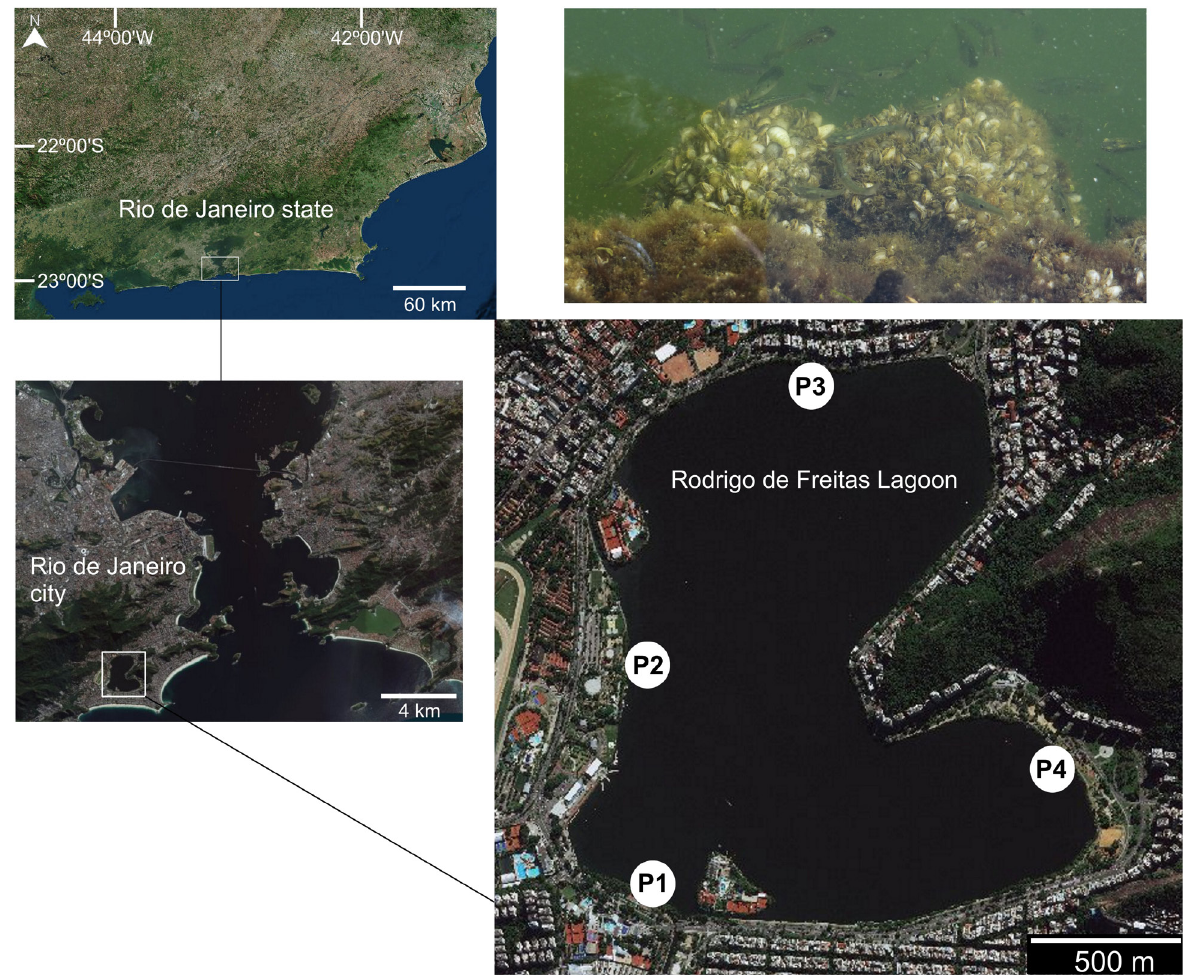
Figure 1. Satellite images of the Rodrigo de Freitas Lagoon (modified from ArcGIS Online), showing the four sampling sites (P1 to P4). Top right: clusters of M. leucophaeata in Rodrigo de Freitas